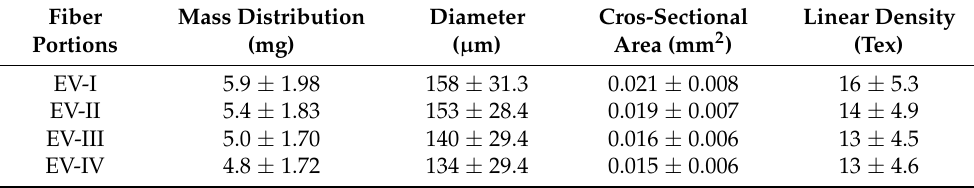
Table 1. The physical properties of Enset fiber (mean value ± standard deviation (STD)).